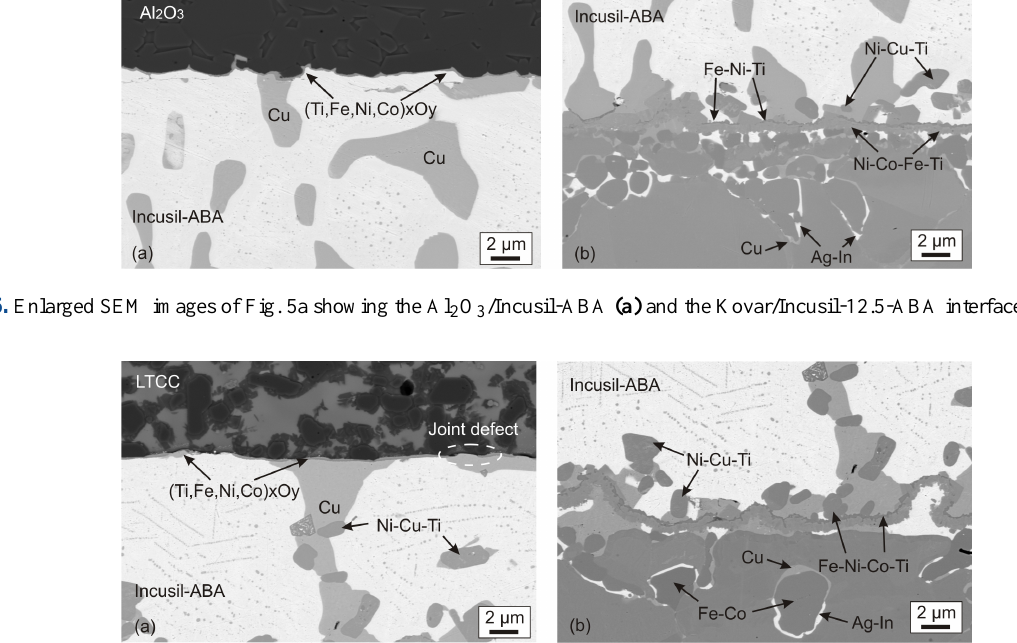
Figure 7. Enlarged SEM images of Fig. 5b showing the LTCC/Incusil-ABA (a) and the Kovar/Incusil-12.5-ABA interfaces (b)